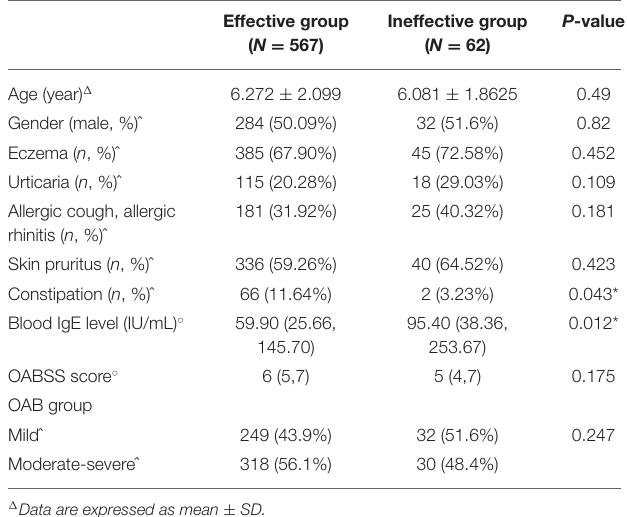
TABLE 5 | Univariate comparison between effective and ineffective desloratadine treatment groups.